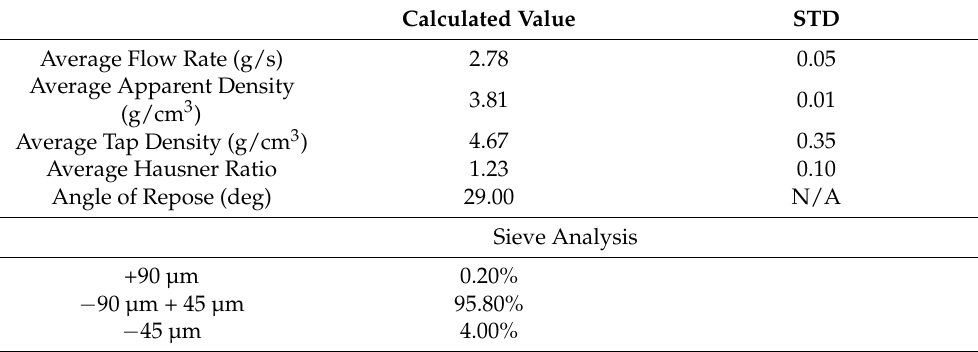
Table 3. Summary of powder powder characterization through sieve